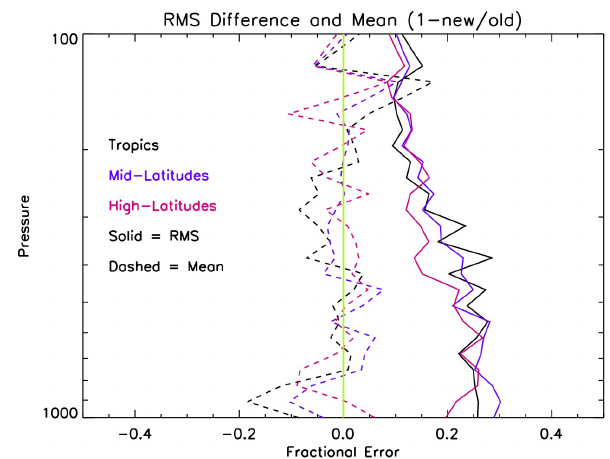
Fig. 3. The RMS and Bias of the fractional difference between the new and old TES H 2 O retrievals. Tropics indicate all latitudes Figure 3: The RMS and Bias of the fractional difference between the new and old TES less than 20 degrees (North and South). Mid-latitudes are between H O retrievals. Tropics indicate all latitudes less than 20 degrees (North and South). 2 20 and 50 degrees (North and South) and High Latitudes are all Mid-­‐latitudes are between 20 and 50 degrees (North and South) and High Latitudes latitudes greater than 50 degrees North (to avoid Antarctica where are all latitudes greater than 50 degrees North (to avoid Antarctica where retrievals retrievals have very low have very low sensitivity).